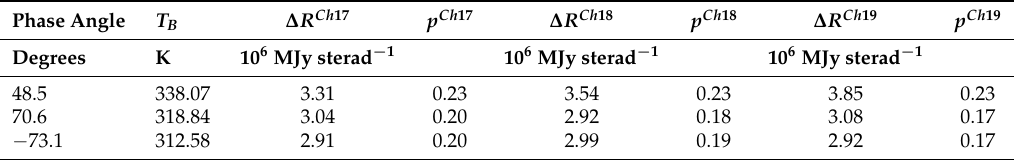
Table 8. Contribution by reflected sunlight to the radiance obtained from the Moon ∆ R and geometric albedo p of the Moon at the central wavelengths of the three SW window channels with HIRS/4. T B is the brightness temperature of the Moon after subtraction of the reflected Sun